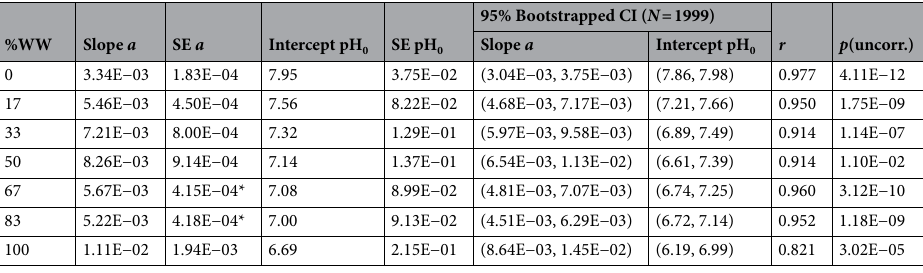
Table 2. pH versus turbidity (T) least squares regression (pH = a T + pH 0 ) statistics for photobioreactors with different proportion of wastewater (%WW) in distilled water (DH 2 O). CI, confidence interval; SE, standard error; p (uncorr.), probability that pH and turbidity are uncorrelated. *Predicted values are 8.40E−04 and 8.9E−04, serially.